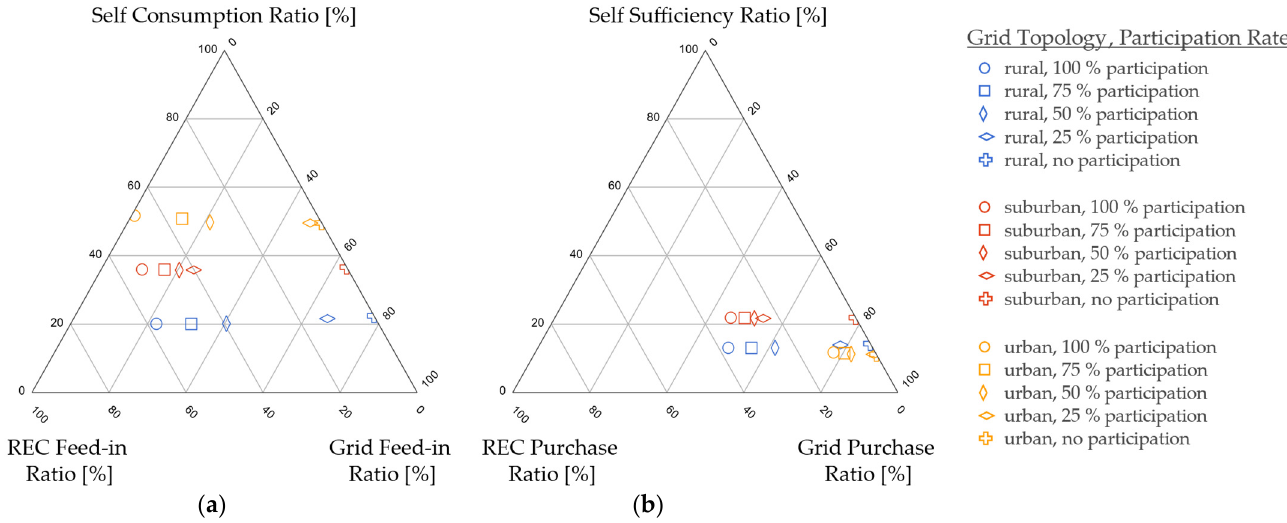
Figure 6. Breakdown based on rural, suburban, and urban simulation cases, different shares of participants, and ‘economic optimum’ operation of ( a ) generated energy into grid feed-in, REC feed-in, and self-consumption ratio, and ( b ) consumed energy into grid purchase, REC purchase, and self-sufficiency ratio.